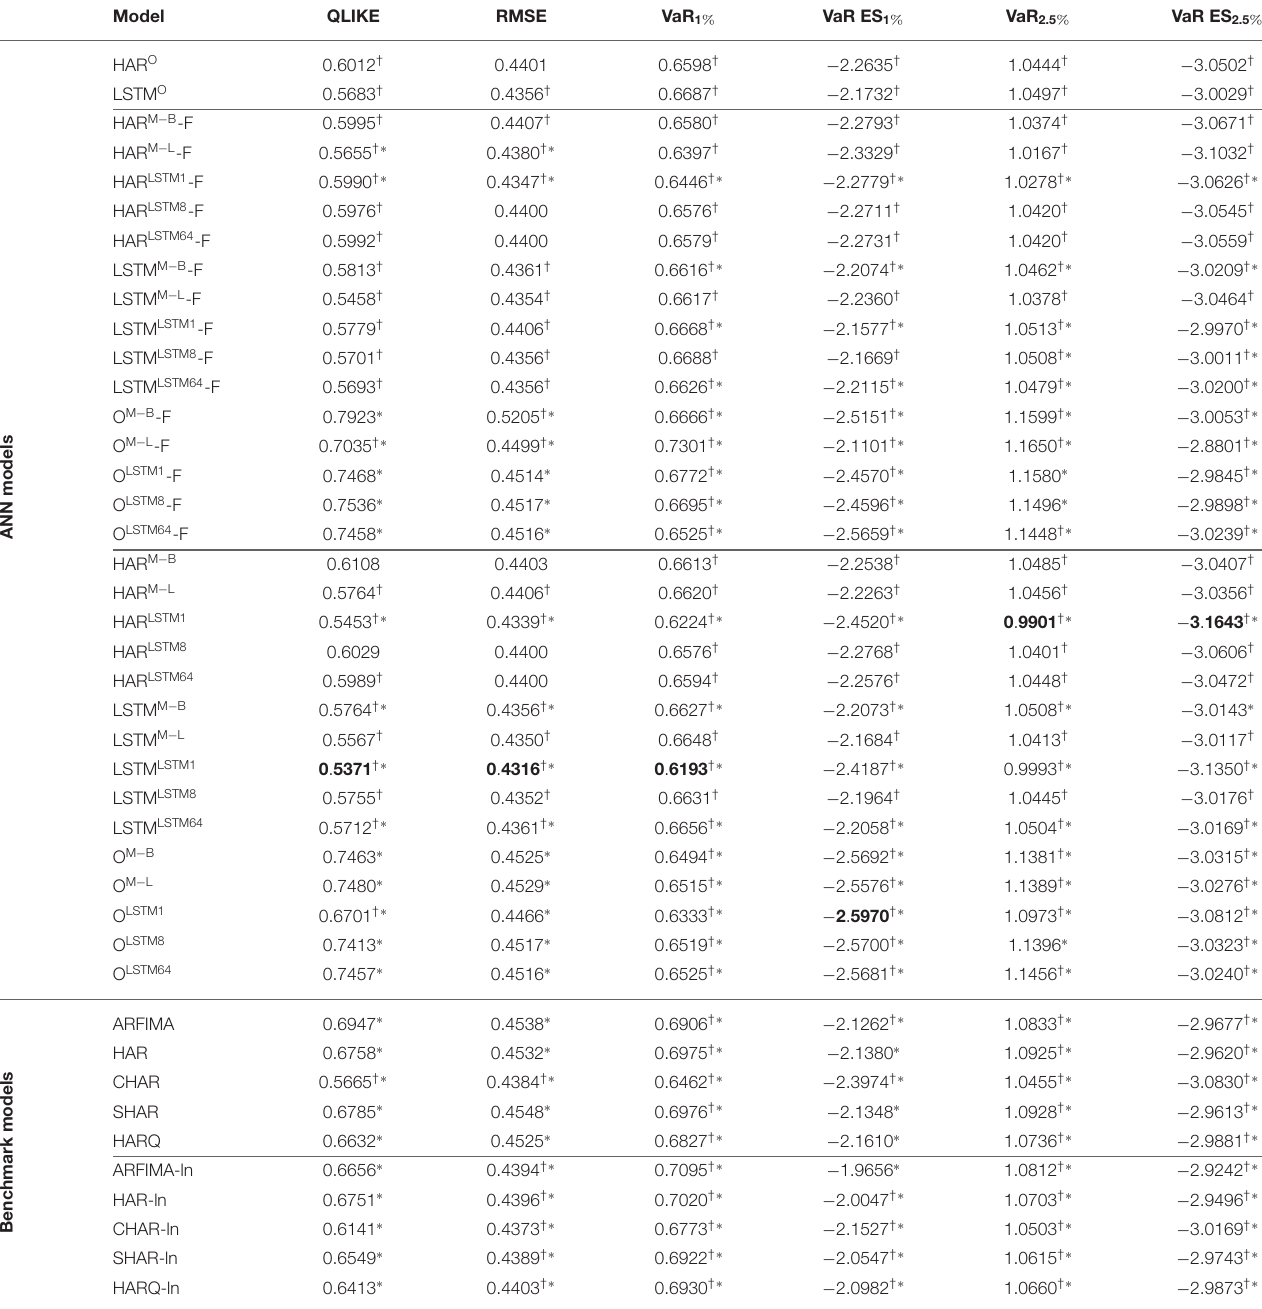
TABLE 2 | Out of sample losses.